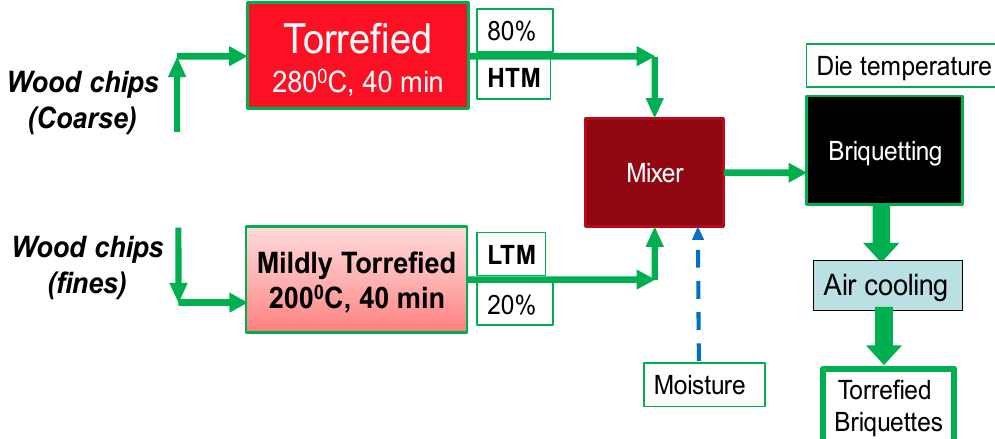
Figure 1. Process schematic to produce briquettes.